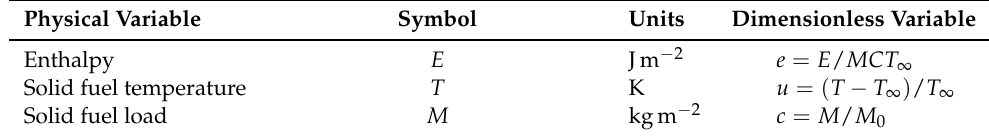
Table 1. Dimensionless unknowns and related physical quantities.